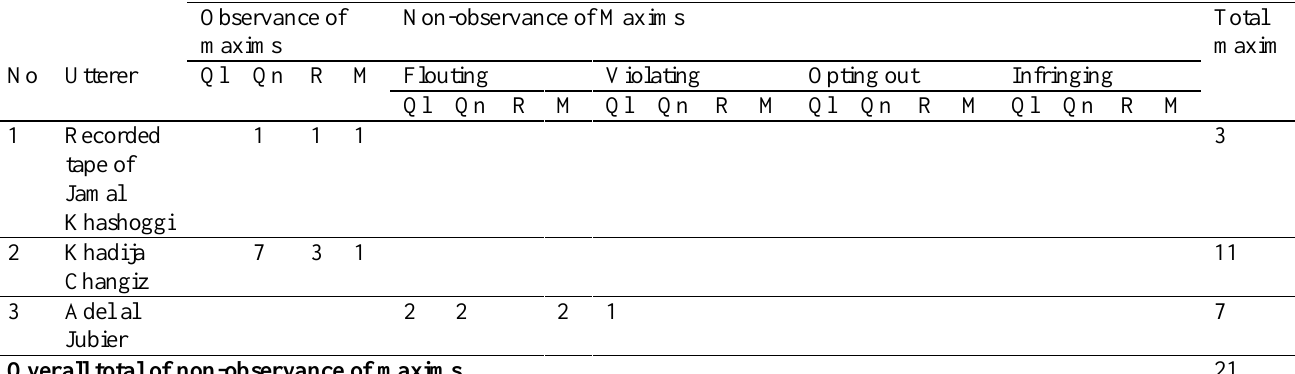
Table 1. The findings of cooperative principles of the study Observance of Non-observance of Maxims Total maxims